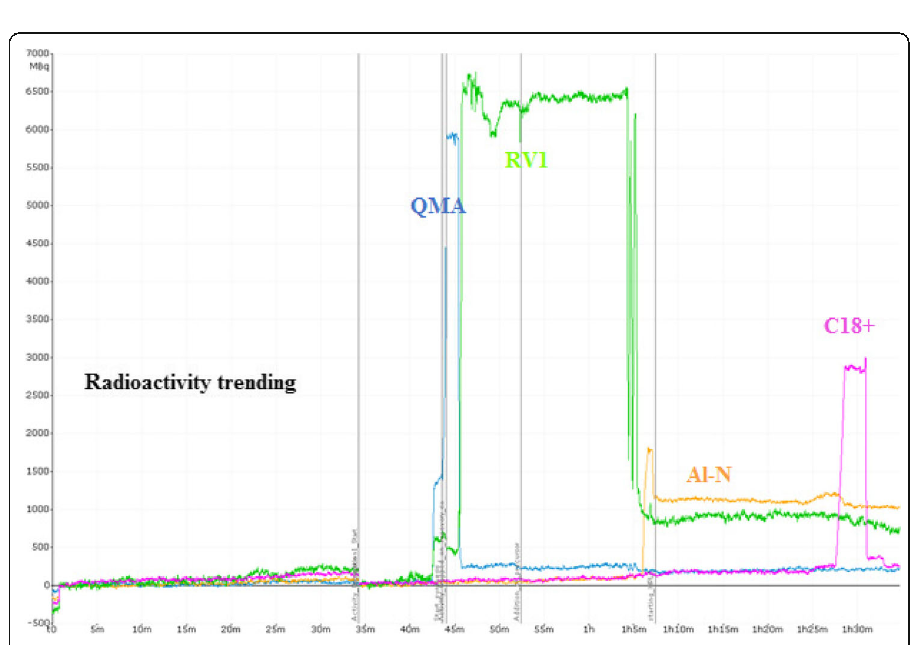
Fig. 6 Radioactivity trending of [ 18 F]ISO-1